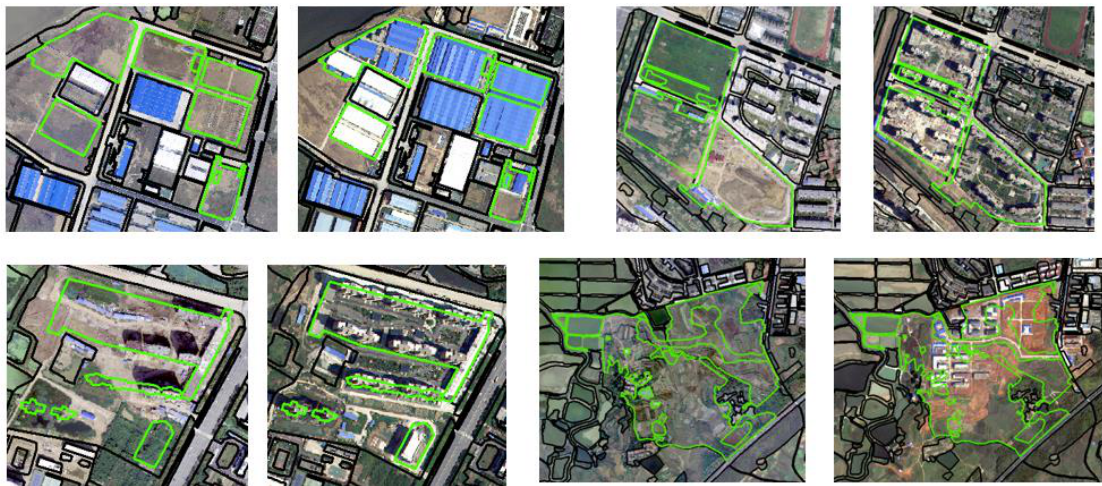
polygons are correctly detected changed polygons, red and blue are false positives and false negatives.